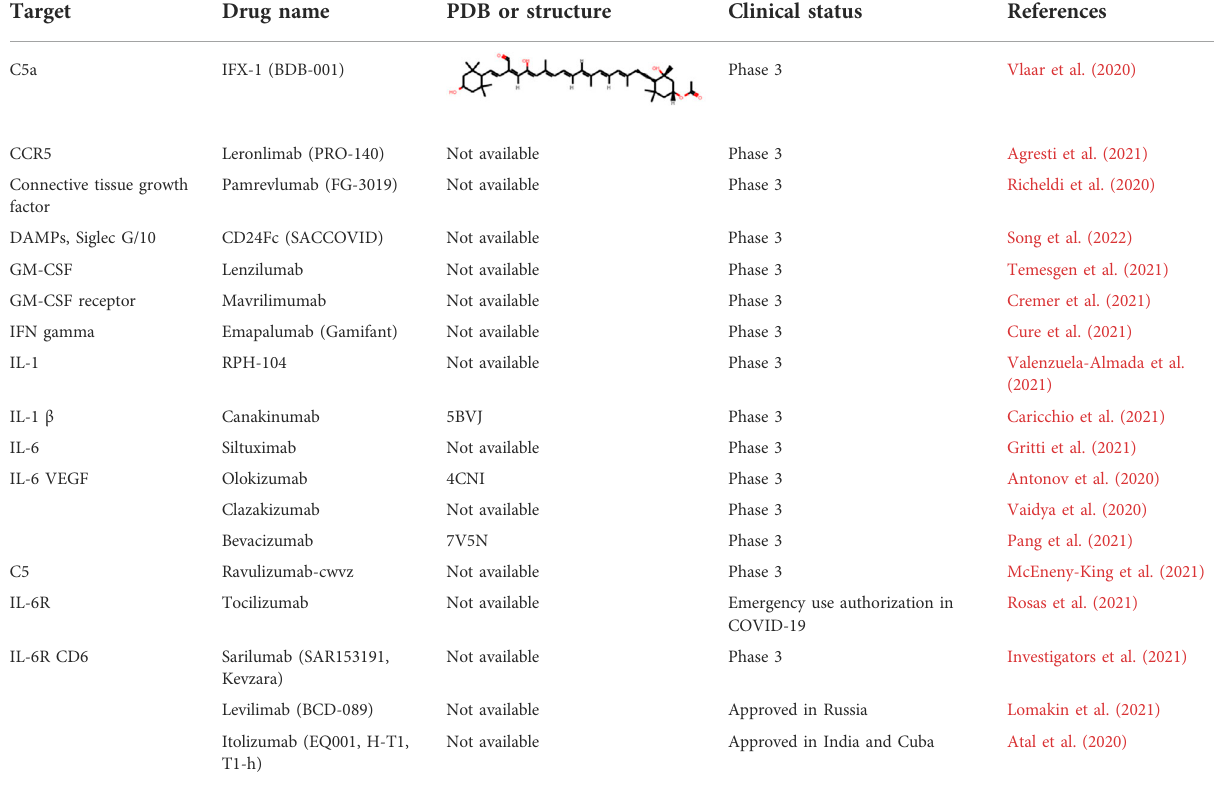
TABLE 4 Inhibitors targeting the immune system and cytokine storm at or after phase three trials.